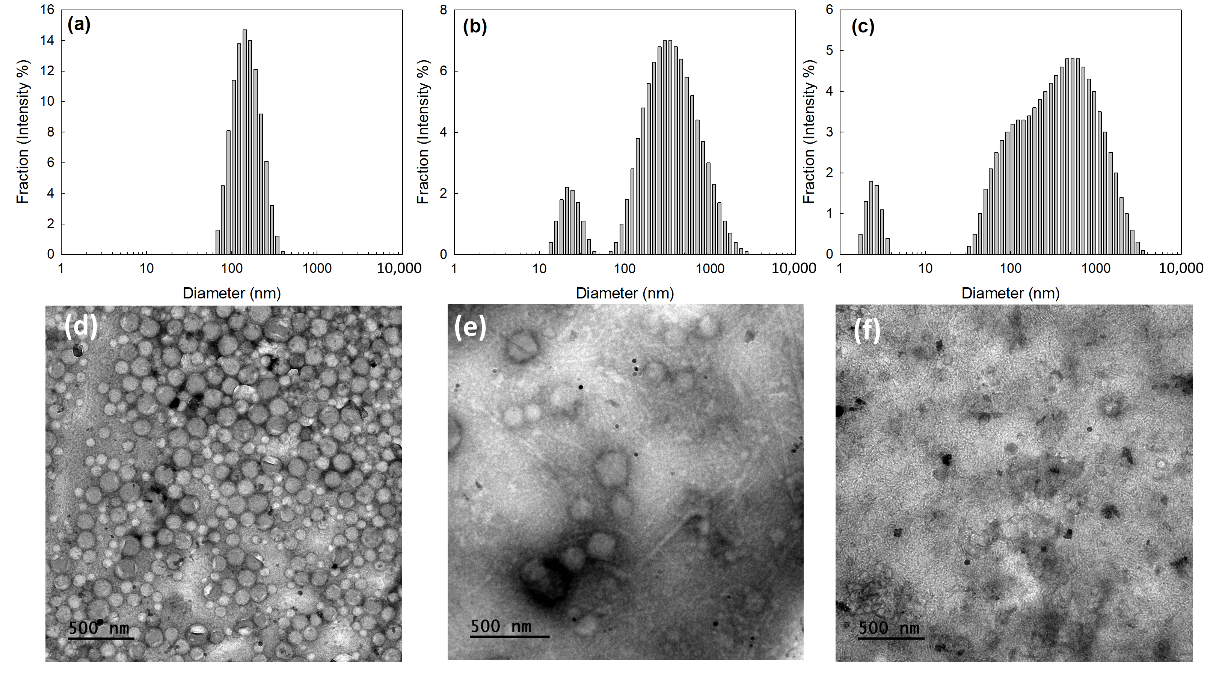
Figure 2. HAthCe6 nanophotosensitizers. ( a ) Particle size distribution and ( b ) TEM image. Average particle size was 146.1 ± 35.3 nm, as described in Table 1. Poly ‐ dispersity index (PDI) was 0.036. For TEM images, nanophotosensitizers were negatively stained with phosphotungstic acid.